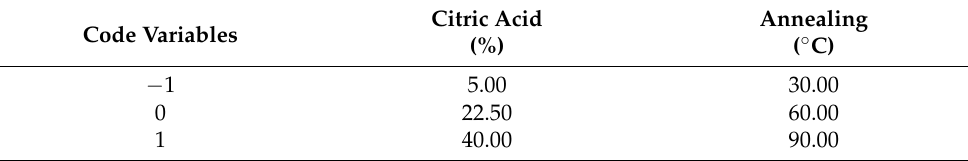
Table 6. Code variables in experimental design for film